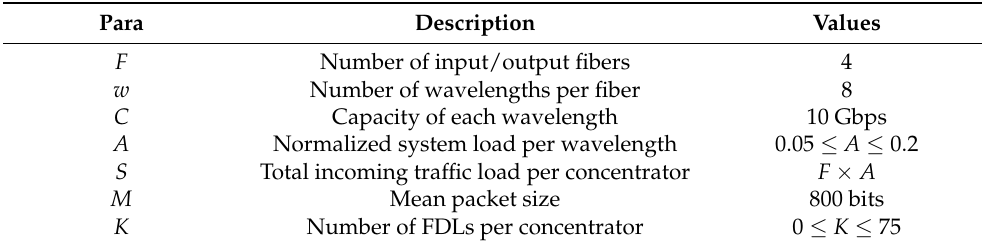
Table 1. The parameters and the corresponding